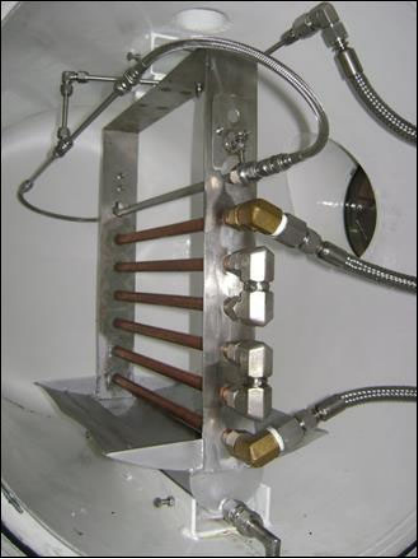
Figure 1. Horizontal tube falling ‐ film absorber built to investigate the absorption process with alkaline nitrate solution [19,20].